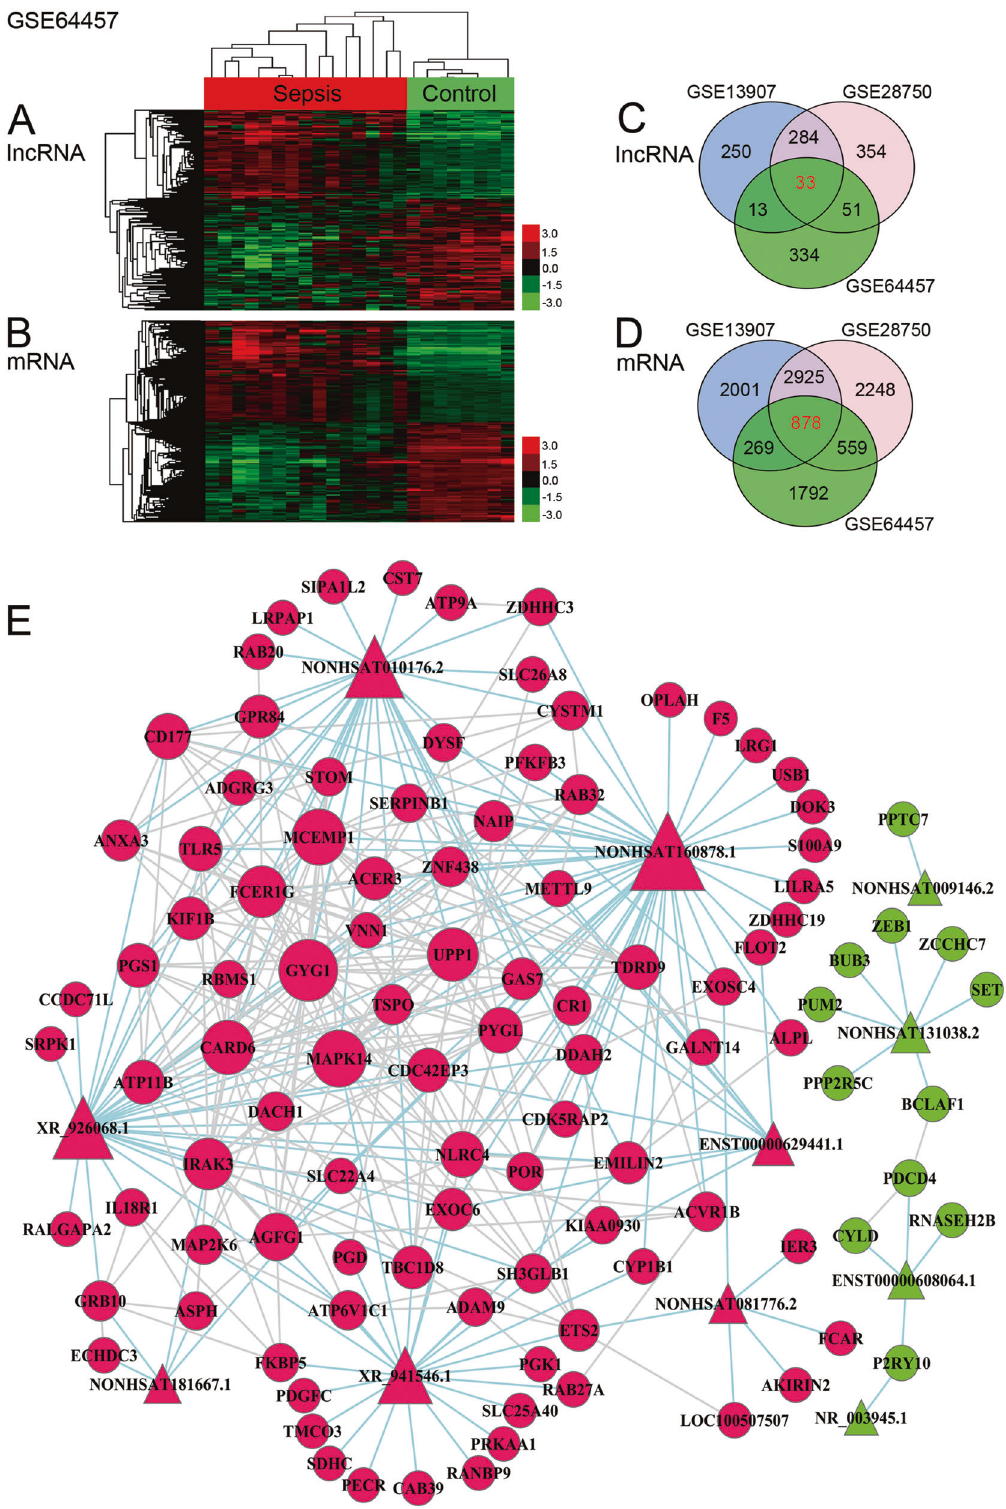
Fig. 1 Identi fi cation of differentially expressed lncRNAs and mRNAs in the immunocytes of septic patients. A Heat map of 431 differentially expressed lncRNAs (including 192 upregulated and 239 downregulated lncRNAs) identi fi ed in the microarrays in the GSE64457 dataset. B Heat map of 3498 differentially expressed mRNAs (including 1765 upregulated and 1733 downregulated mRNAs) identi fi ed in the microarrays in the GSE64457 dataset. C Venn plot of the 1319 differentially expressed lncRNAs in the 3 datasets. D Venn plot of the 10,672 differentially expressed mRNAs in the 3 datasets. E Co-expression network of the signi fi cantly differentially expressed lncRNAs and mRNAs. Circles indicate mRNAs and triangles indicate lncRNAs. Red represents upregulated expression and green represents downregulated expression. Baby blue lines indicate the interaction between lncRNAs and mRNAs, and gray lines indicate mRNAs interacting with other mRNAs.